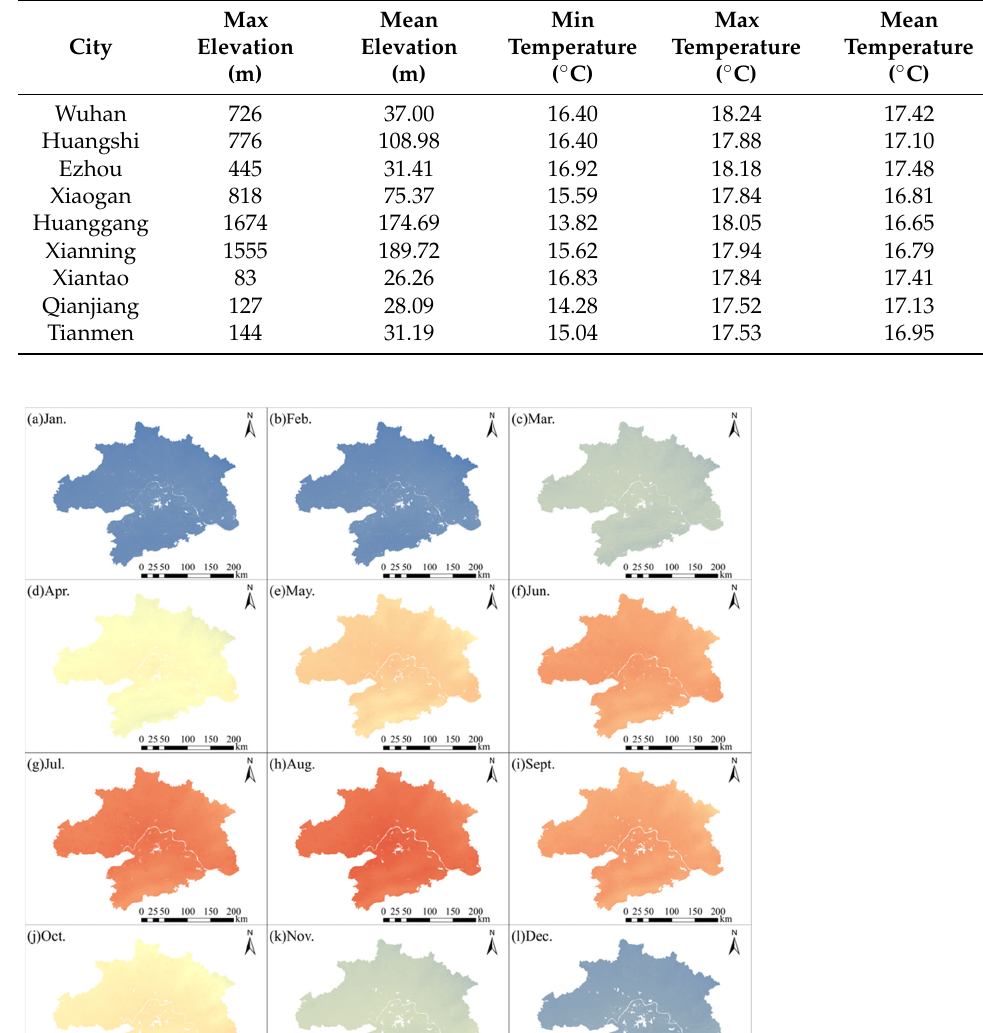
Figure 10. The temporal variation of fusion temperature in each month 2019, The black dots repre- sent outliers. Moreover, we compared the spatial distribution of fusion temperature data with that of ERA5-Land temperature, as shown in Figure 11. It is clear that the spatial distribution of temperature data generated by DBN model is basically the same as that of ERA5-Land temperature. Meanwhile, DBN model successfully captured the overall spatial variation trend of temperature in WMA and showed more subtle spatial details. For example, the spatial variation of fusion temperature data in the northeast and central parts of WMA is more detailed than that of ERA5-Land temperature products, as we can see in the red